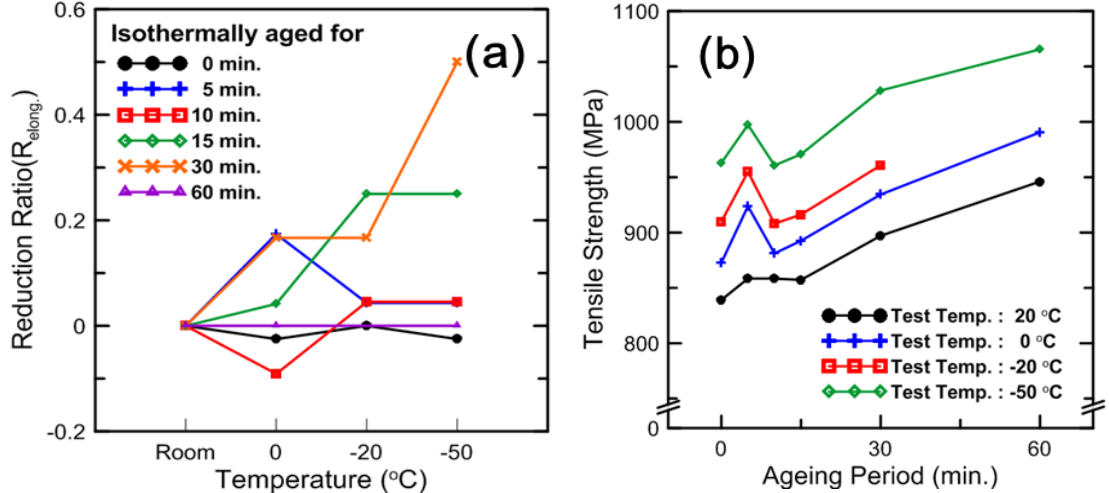
Figure 9. Effect of test temperature on mechanical behavior of the precipitated SDSS: ( a ) elongation and ( b ) tensile